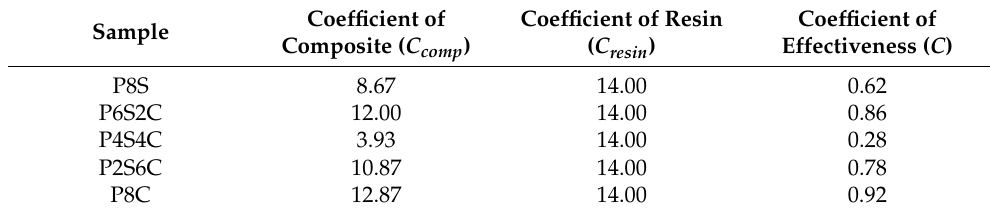
Table 2. Coefficient of filler